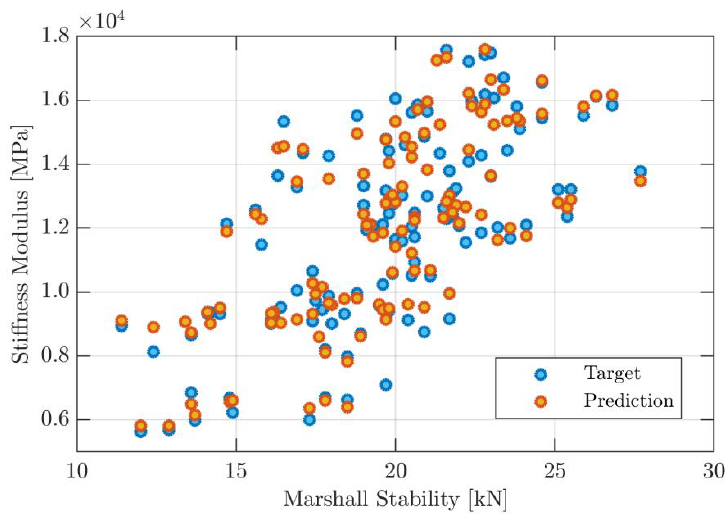
Figure 8. Comparison between experimental target and MS SNN output on the training data set.